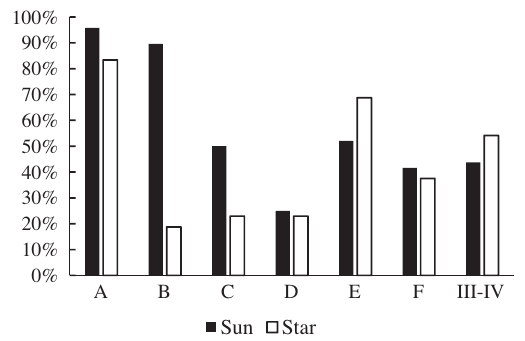
FIG. 5. Percentage of the university students with a correct answer on the Sun and star